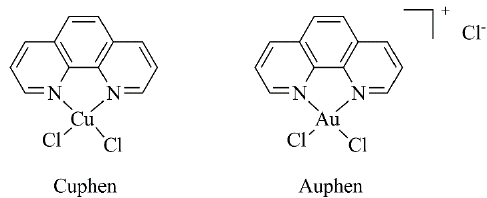
Figure 2. Chemical structures of Cuphen and Auphen.